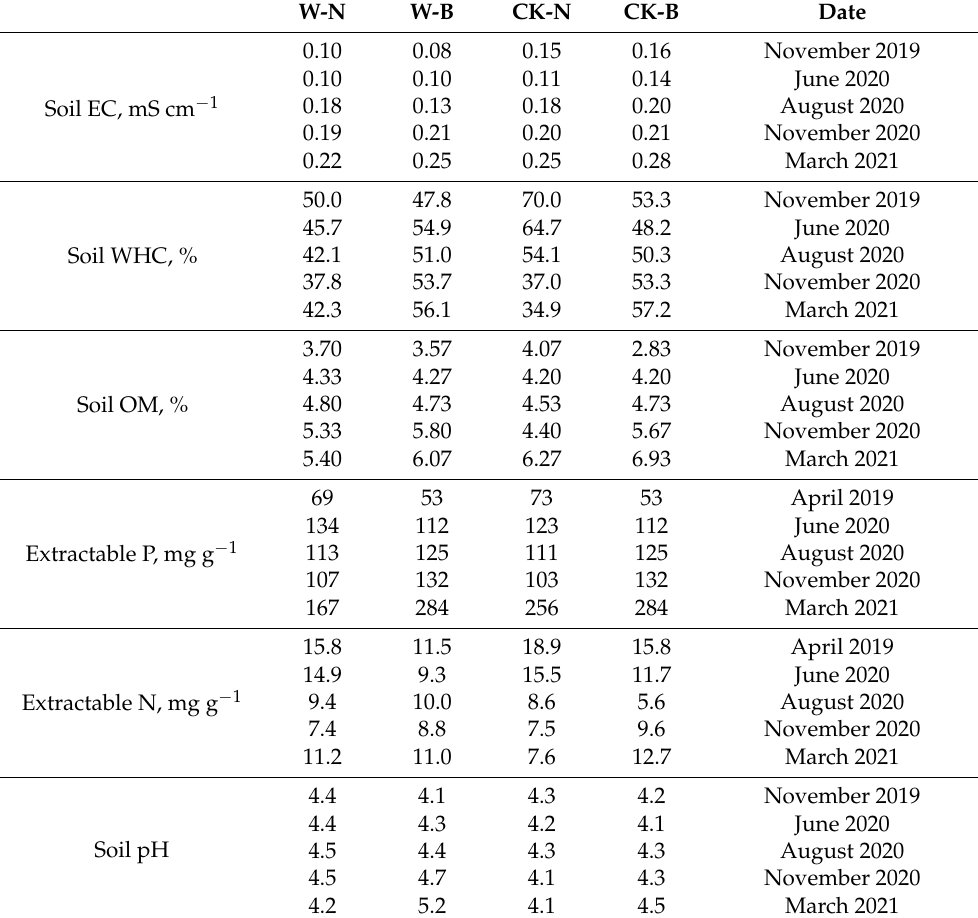
Table A1. The soil characteristics under biochar application from 2019 to 2021. W-B means weak tea growth (W) with biochar applied (B); CK-N means normal tea growth (CK) without biochar